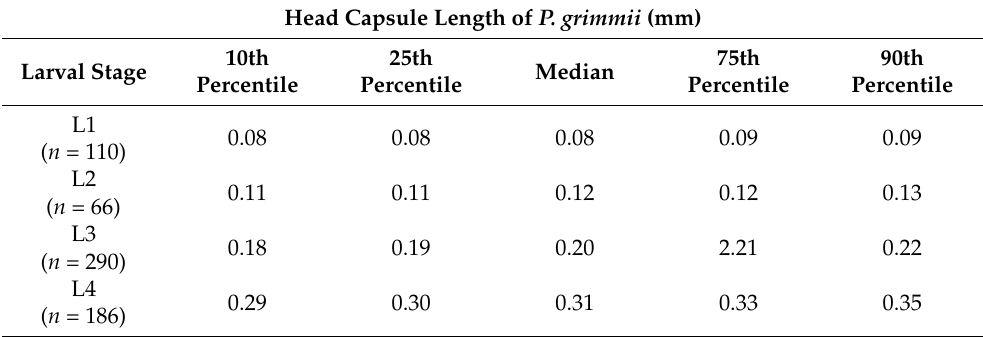
Table 2. The head capsule lengths of the Paratanytarsus grimmii larval stages.